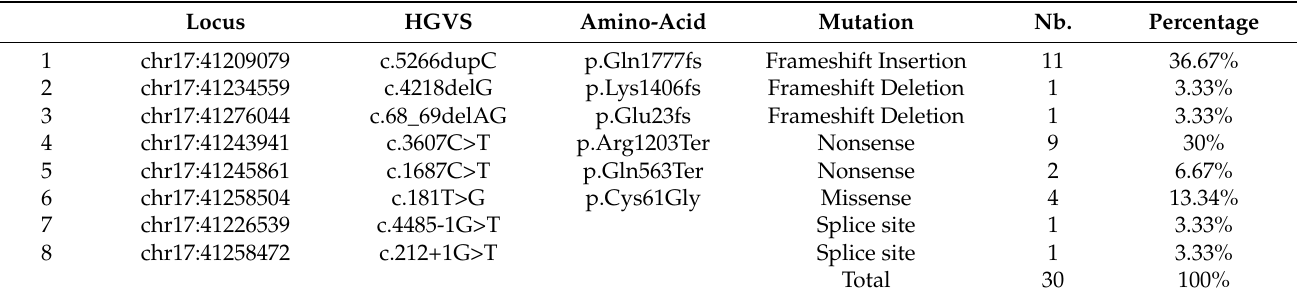
Table 4. BRCA1 mutation rate (according to the Human Genome Variation Society (HGVS)) and its link to BC in the analyzed group.